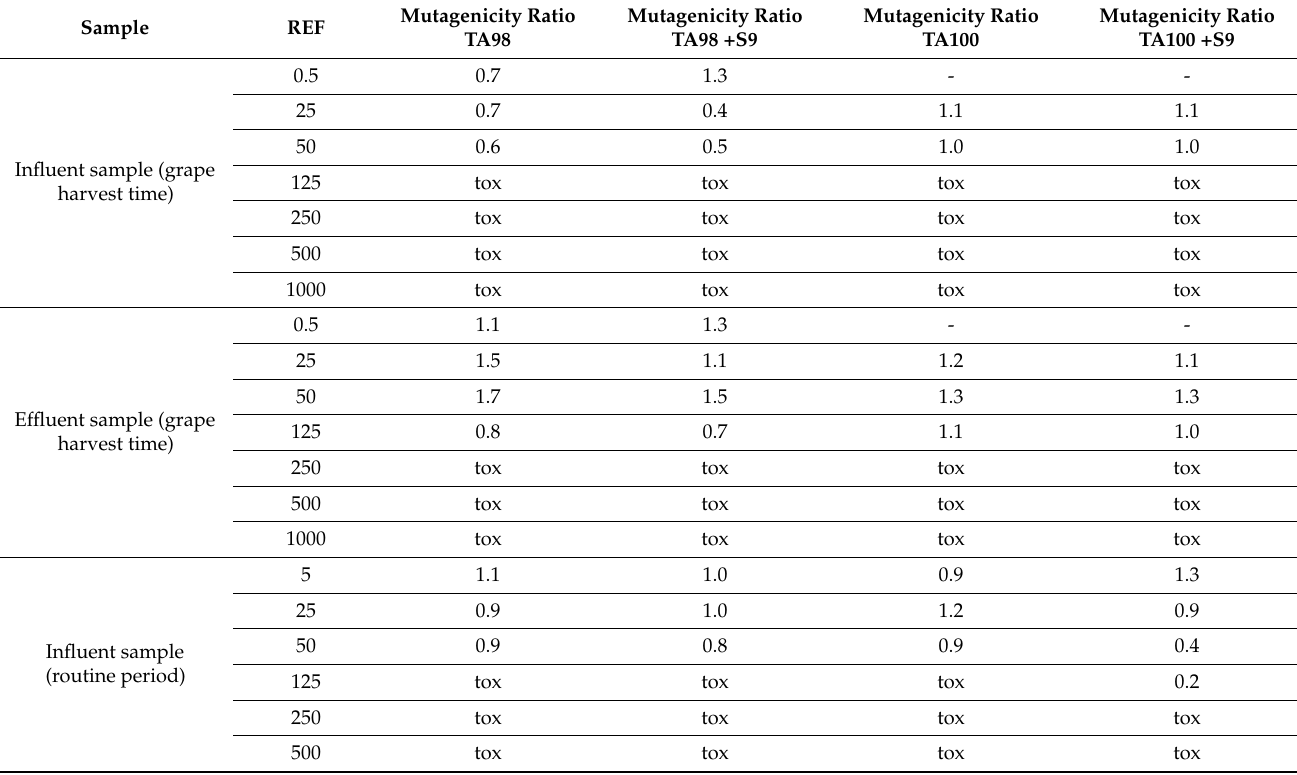
The results of Ames test, expressed as mutagenicity ratio, are presented in Table 11. Table 11. Results of Ames test on Salmonella typhimurium TA98 and TA100 strain ± S9 expressed as mutagenicity ratio (MR) and REF